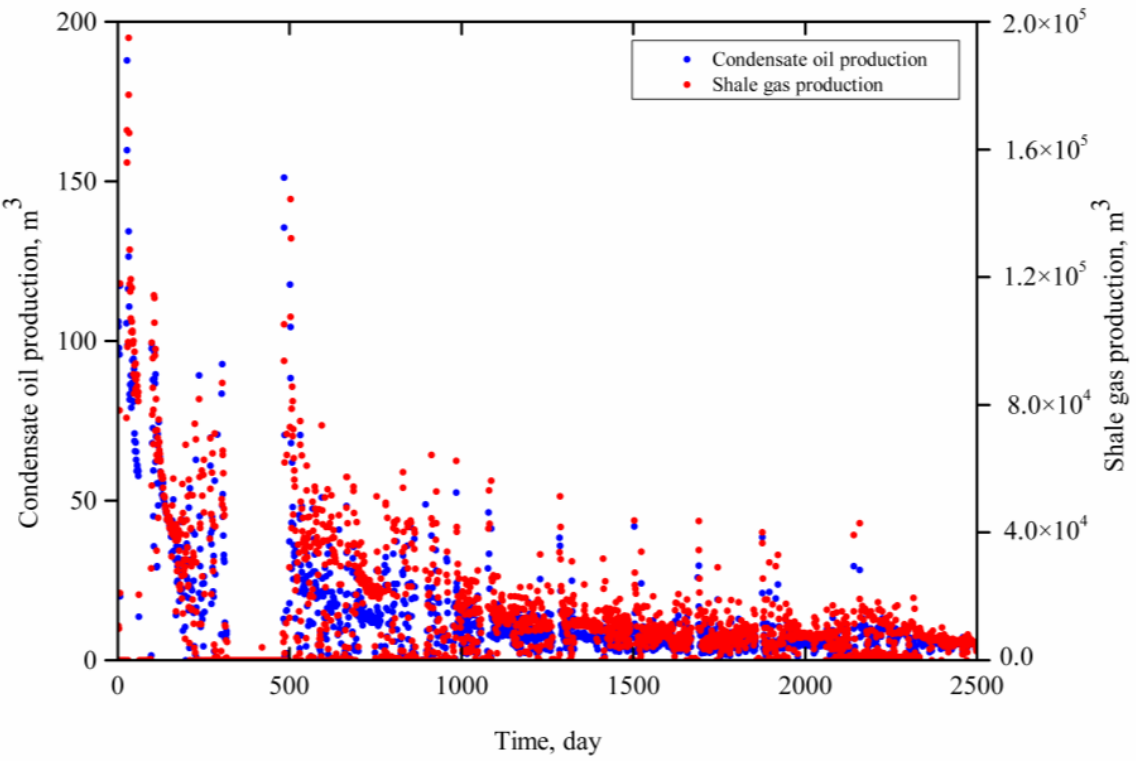
Figure 4. Daily output of condensate oil and shale gas in a multi-stage fractured horizontal well.